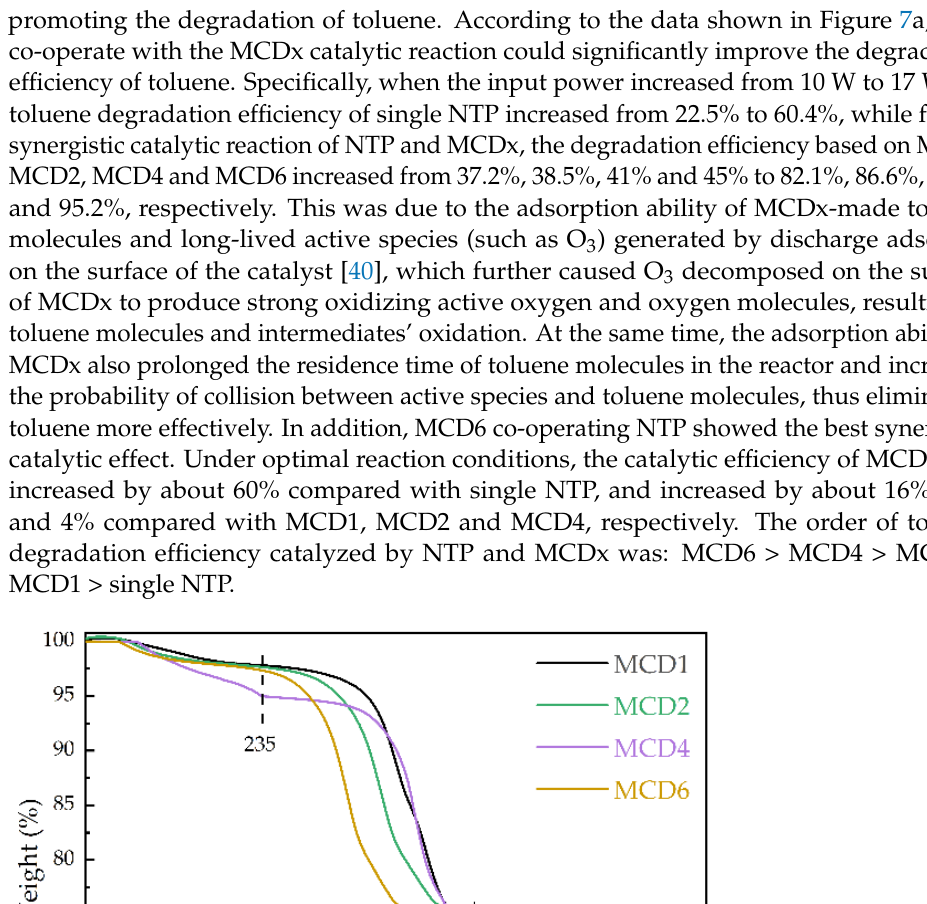
Figure 5. FTIR curves of MCDx catalysts.